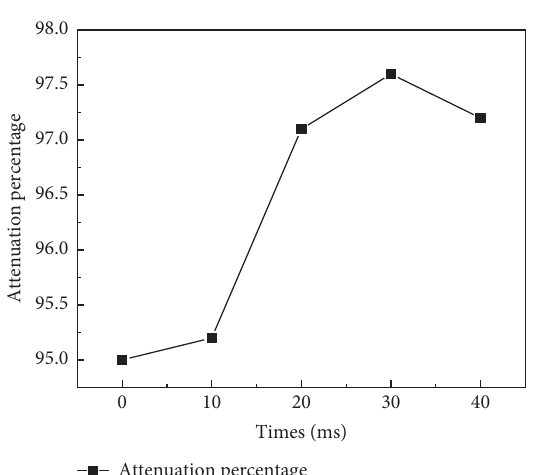
Figure 7: Attenuation ratio of peak pressure at 10m water